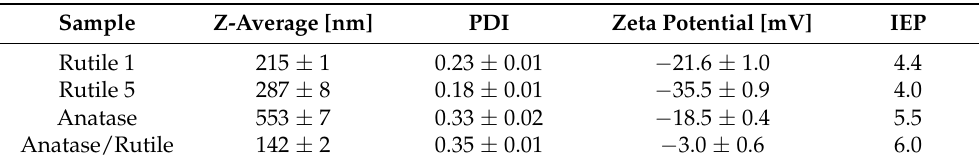
Table 2. The diameter and PDI of TiO 2 particles dispersed in water together with zeta potentials determined in water with pH adjusted to 7 and IEPs of studied samples.